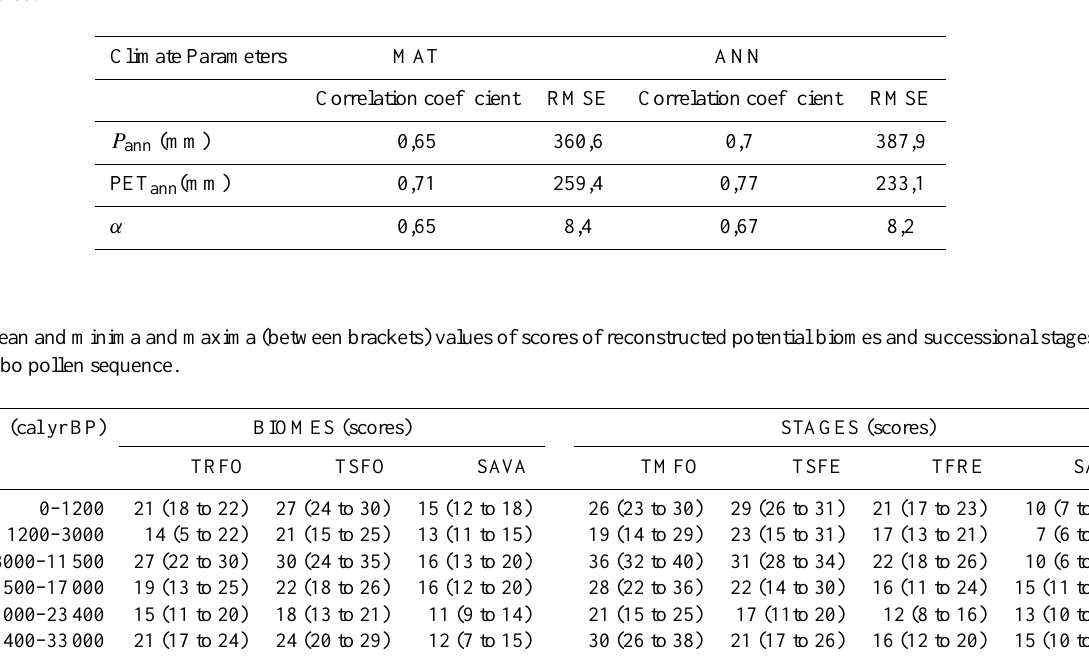
Table 4. Correlation coefficients between observed and reconstructed values of climate parameters reconstructed from modern pollen samples.